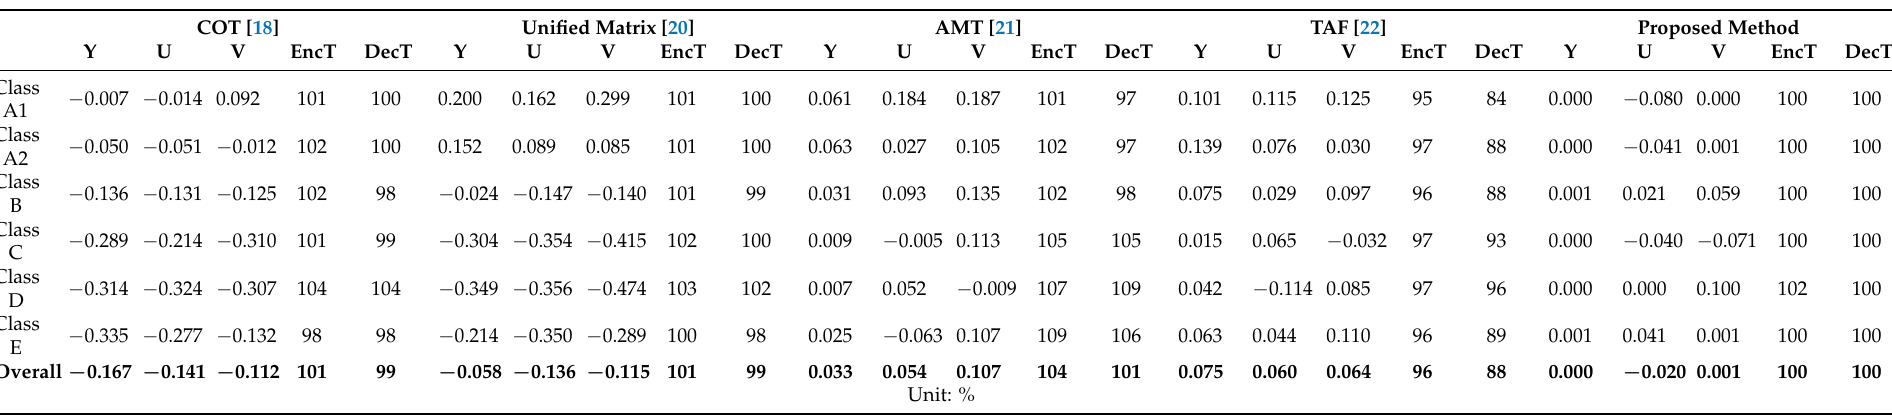
Table 3. Comparison of the overall simulation results for the derivation of transform kernels with the proposed method (AI).